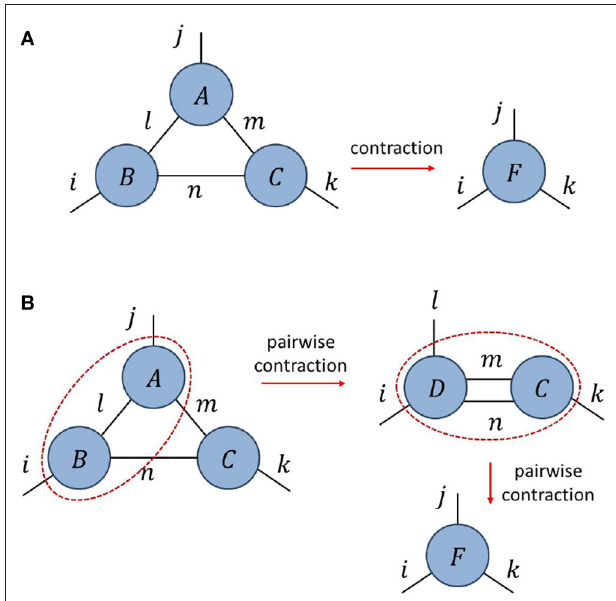
FIGURE 2 | (A) The internal indices ( l , m , n ) of the network { A , B , C } are contracted to give tensor F . (B) The network is contracted via a sequence of two pairwise tensor contractions, the first of which results in the intermediate tensor D